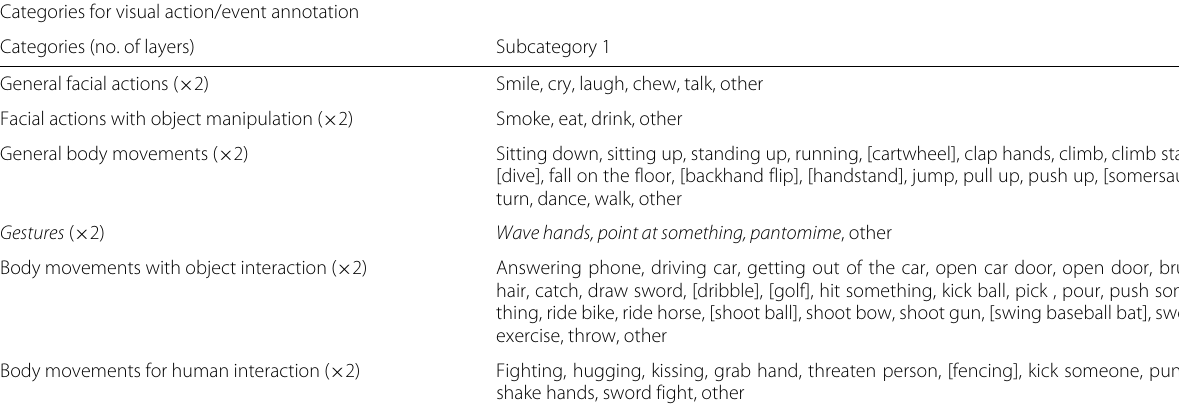
Table 5 Categories for visual action/event annotation Categories for visual action/event annotation Categories (no. of